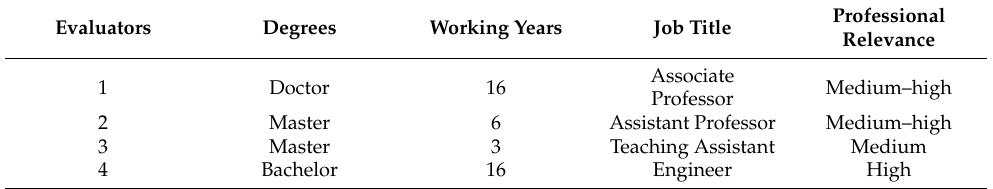
Table 2. Information of selected evaluators of the reliability of HFACS-GE